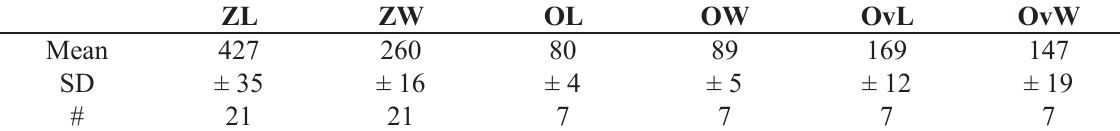
Table 9. Measurements of Atlantisina gorringensis gen. et sp.